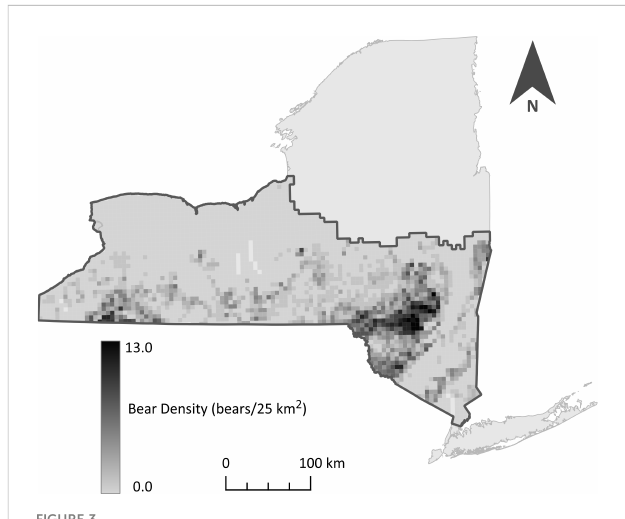
FIGURE 3 Information on density of black bears ( Ursus americanus) per 25 square kilometers in New York State, USA in 2017 and 2018 (data from Sun, 2019 and Sun et al., 2019). Dark line delineates the study area perimeter. Darker shading indicates higher bear density.